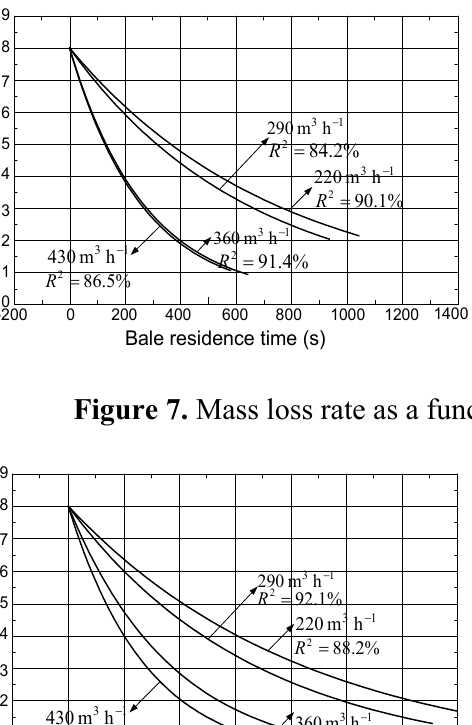
Figure 6. Mass loss rate as a function of time, recirculation 0%.